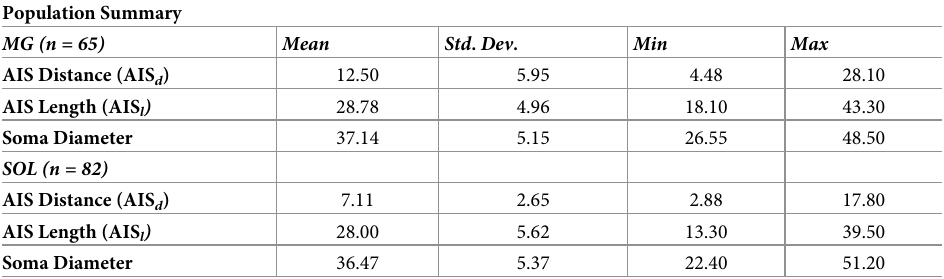
Table 1. Population data measurements from retrogradely labeled MG and SOL